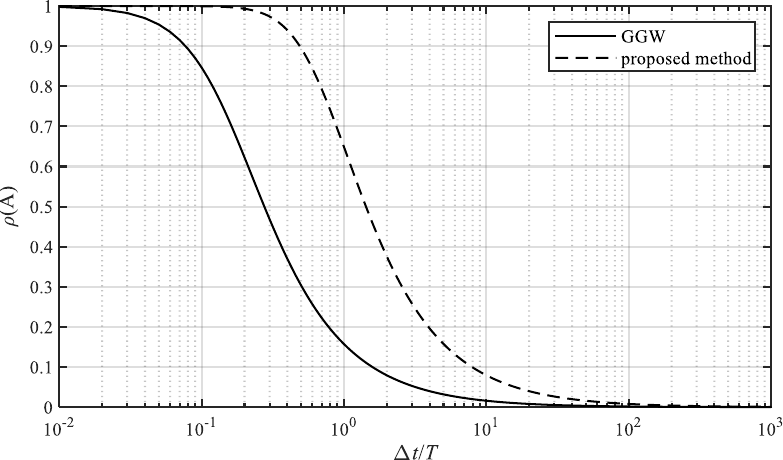
Figure 4. The spectral radius of transfer matrix of the proposed method ( β = 1/2) and the GGW method when ρ ∞ = 0 .